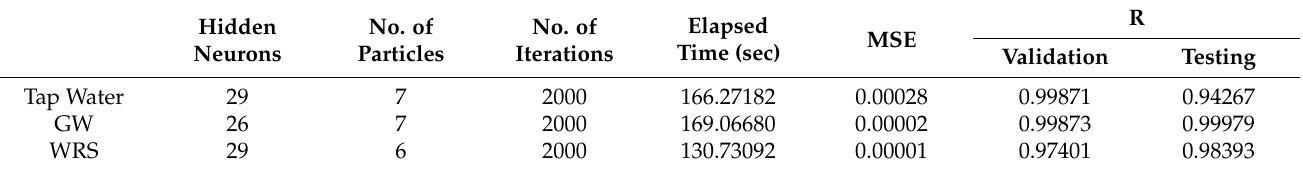
Figure 19. Spatial maps of TCR (child) developed using MLGI approach for ( a ) TW samples, ( b ) GW samples, and ( c ) WRS samples.